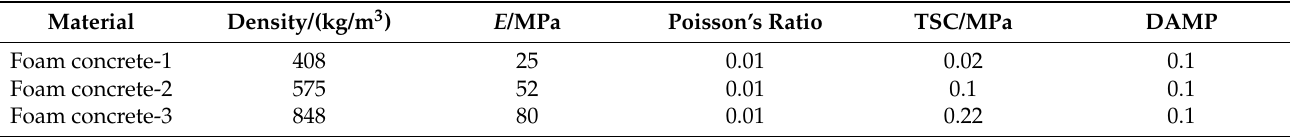
Table 2. Material parameters of foam concrete in the numerical